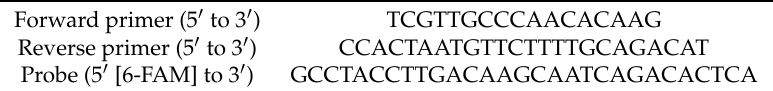
Table 1. The primer and probe sets used in reverse transcription quantitative polymerase chain reaction (RT-qPCR) to quantify ZIKV encapsulated